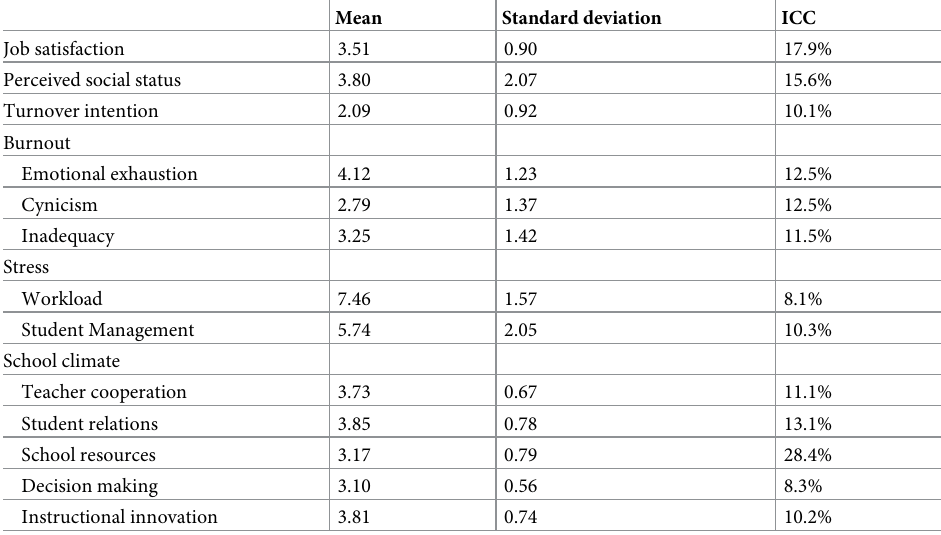
Table 9. Scores on scale variables of attitudes towards work and variance explained at school level.